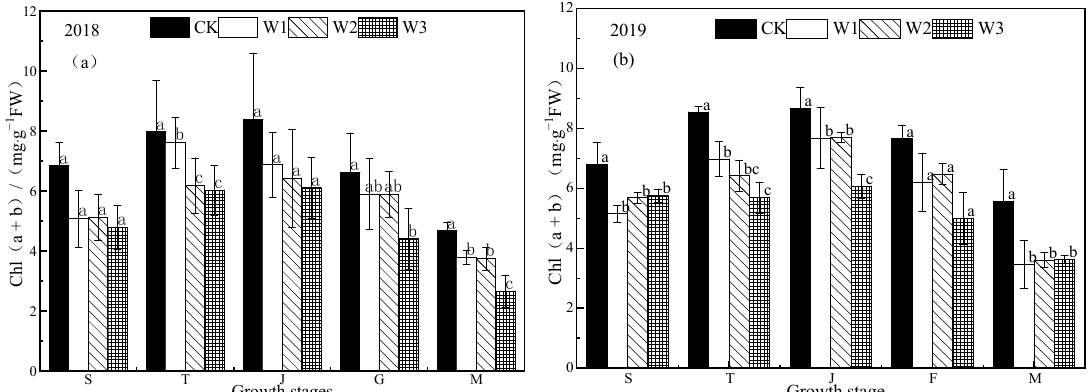
Figure 2. Changes in chlorophyll content in rice under water stress in ( a ) 2018 and ( b ) 2019. CK: flooding treatment, W1: Irrigation limit 0.65–1.00 θ s, W2: Irrigation limit 0.75–1.00 θ s, and W3: Irrigation limit 0.85–1.00 θ s. S, T, J, F, and M represent the seedling, tillering, jointing, grouting, and mature stages, respectively. The data are the mean ± standard error. Different letters indicate significant differences between treatments p < 0.05.